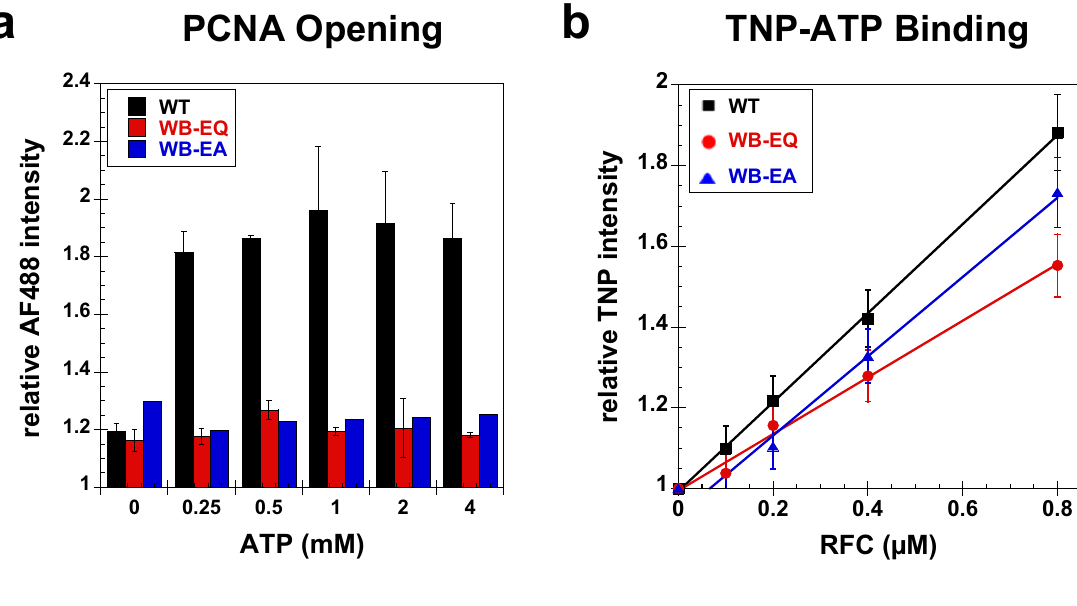
Figure 4. ATP binding to WT RFC and WB mutants measured by PCNA opening and TNP-ATP fluorescence. ( a ) Binding of WT RFC (black), the WB-EQ RFC mutant (red) and the WB-EA RFC mutant (blue) to PCNA-AF488 was measured in assays using the ATP concentrations indicated. The relative intensity of AF488 at 517 nm is plotted as a function of ATP concentration for solutions containing 10 nM PCNA-AF488 and 250 nM each